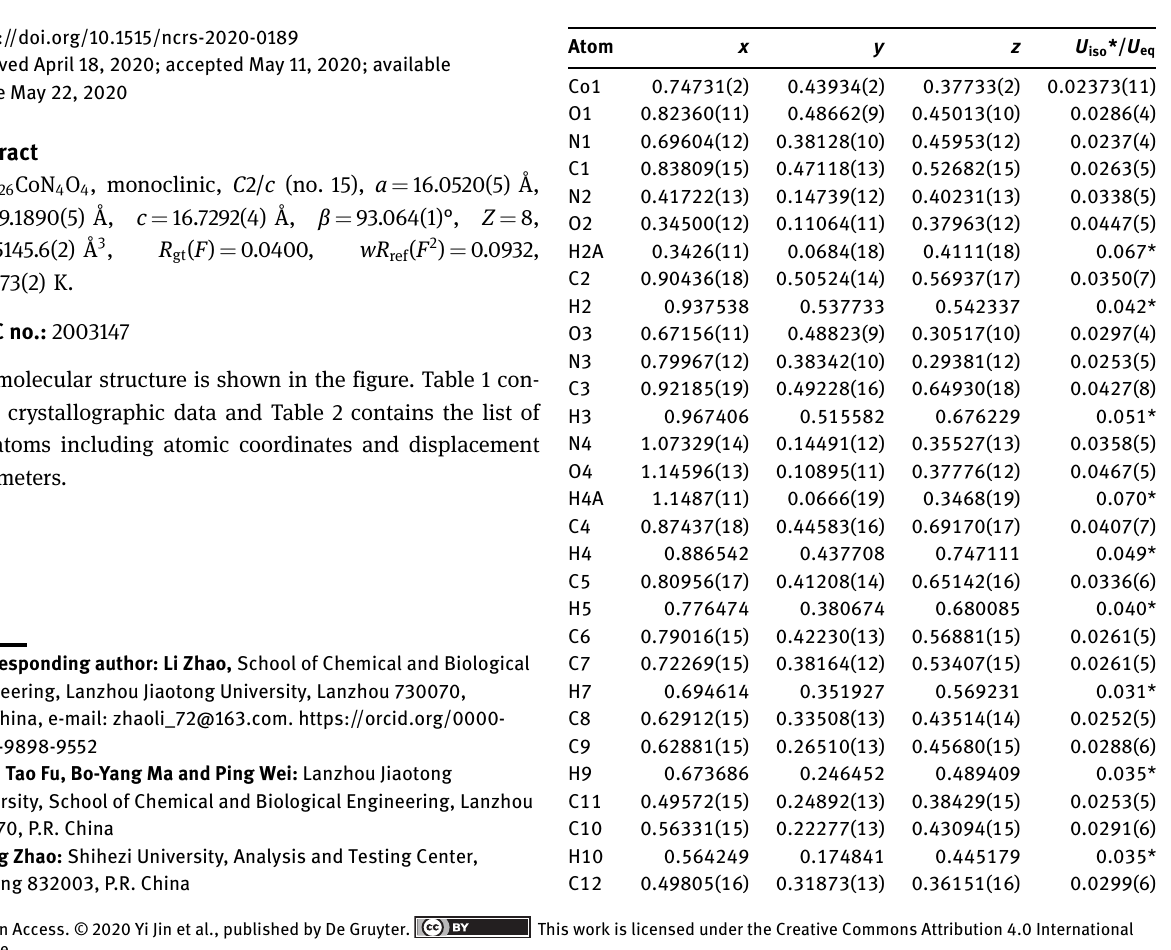
Table 2: Fractional atomic coordinates and isotropic or equivalent isotropic displacement parameters (Å 2